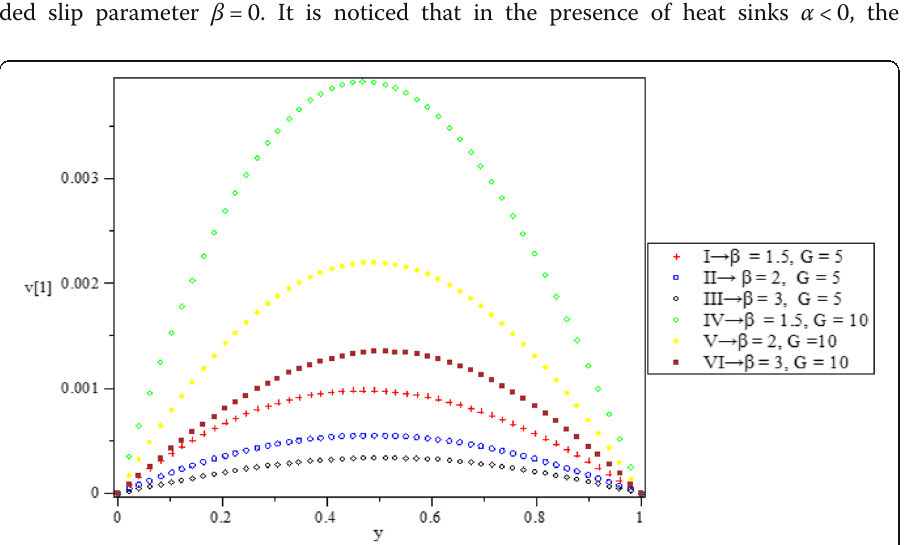
Fig. 26 First-order velocity (v[1] profile, r = − 1, ϵ = 0.25, P = 0.71 α = 0, and λ =